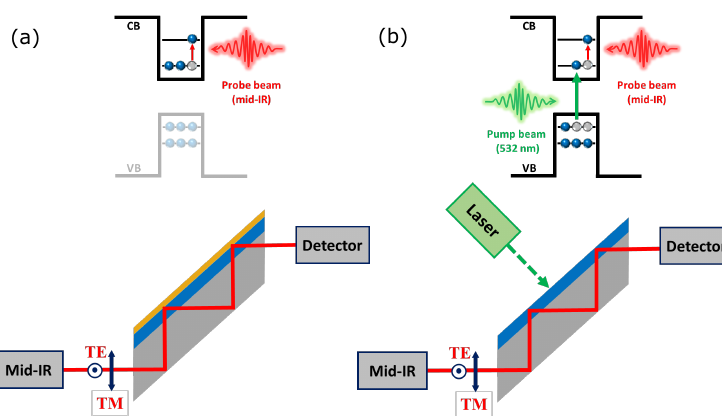
Figure 1. ( a ) (upper panel) Schematic of the absorption spectroscopy of Mid-Infrared (MIR) photons within a doped Quantum Well (QW). The 1st subband (conduction band) is filled with electrons and MIR photons are absorbed by the quantized states. (lower panel) Schematic of the experimental approach with a 45 ◦ facets multipass prism. The sample is probed in both Transverse Electric (TE) polarization and Transverse Magnetic polarization (TM) ( b ) (Upper Panel) Schematic representation of the photo-induced absorption spectroscopy with nominally undoped QW. Electrons are promoted from the valence band up to the conduction band using a continuous wave laser at 532 nm. MIR photons are then absorbed by the quantized states. (lower panel) Schematic of the experimental approach with a 45 ◦ facets multipass prism illuminated by a CW laser.